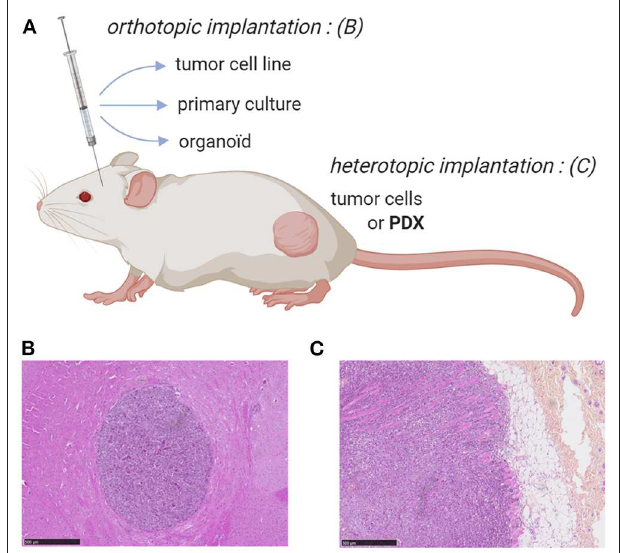
FIGURE 1 | Mouse models for ortho- or heterotopic administrations of human tumor cells. (A) Schematic representation of human tumor cell implantation strategies in immunodeficient mouse (e.g., NSG). Human tumor cells from either cell lines, primary/organoid cultures or patient-derived xenograft can be implanted orthotopically or heterotopically, respectively. (B,C) Immunohistochemistry (hematoxylin and eosin stainings) of orthtopic (brain) implantation of cells from a primary culture of human glioblastoma (GBM-1) (B) and heterotopic (subcutaneous) implantation of human prostate cancer cells (PC-3 cell line) (C) . Bars: 500 µ m. NJ & ES, unpublished